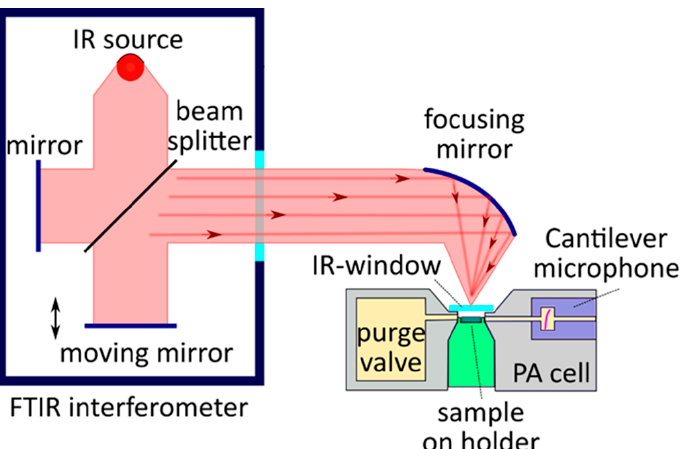
Figure 12. Schematic view of a typical photoacoustic Fourier transform infrared (PA FT-IR) setup.